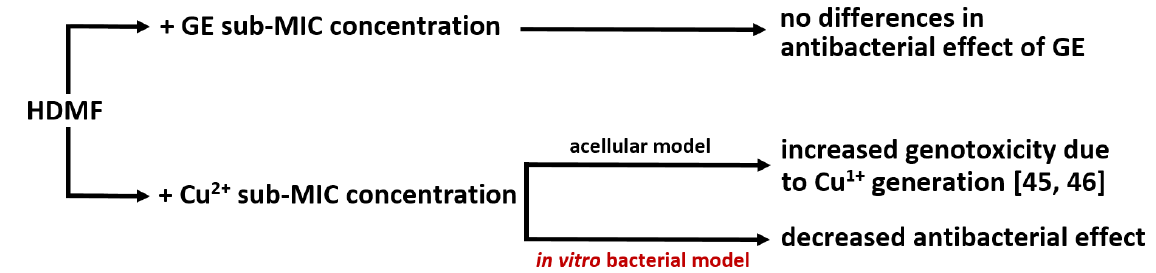
Figure 6. The antibacterial activity of HDMF in combination with GE and Cu 2+ ; no enhancement nor decrease in efficacy of GE was observed when combined with HDMF; Cu 2+ combination with HDMF in an acellular model increase genotoxicity, contrary to the reduced antibacterial effect in in vitro bacterial model (red fonts).